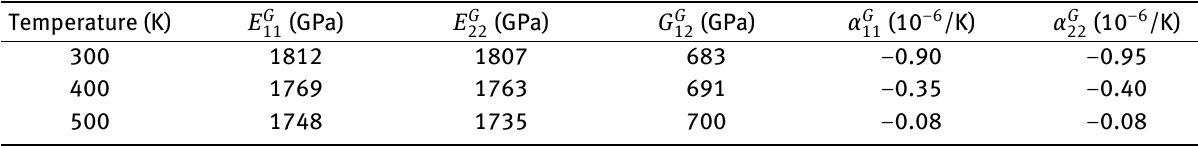
Table 1: Temperature-dependent material properties of monolayer graphene ( a G = 14.76 nm, b G = 14.77 nm, thickness h G = 0.188 nm, ν G 0.177, ρ G = 4118 kg/m 3 ) [46].